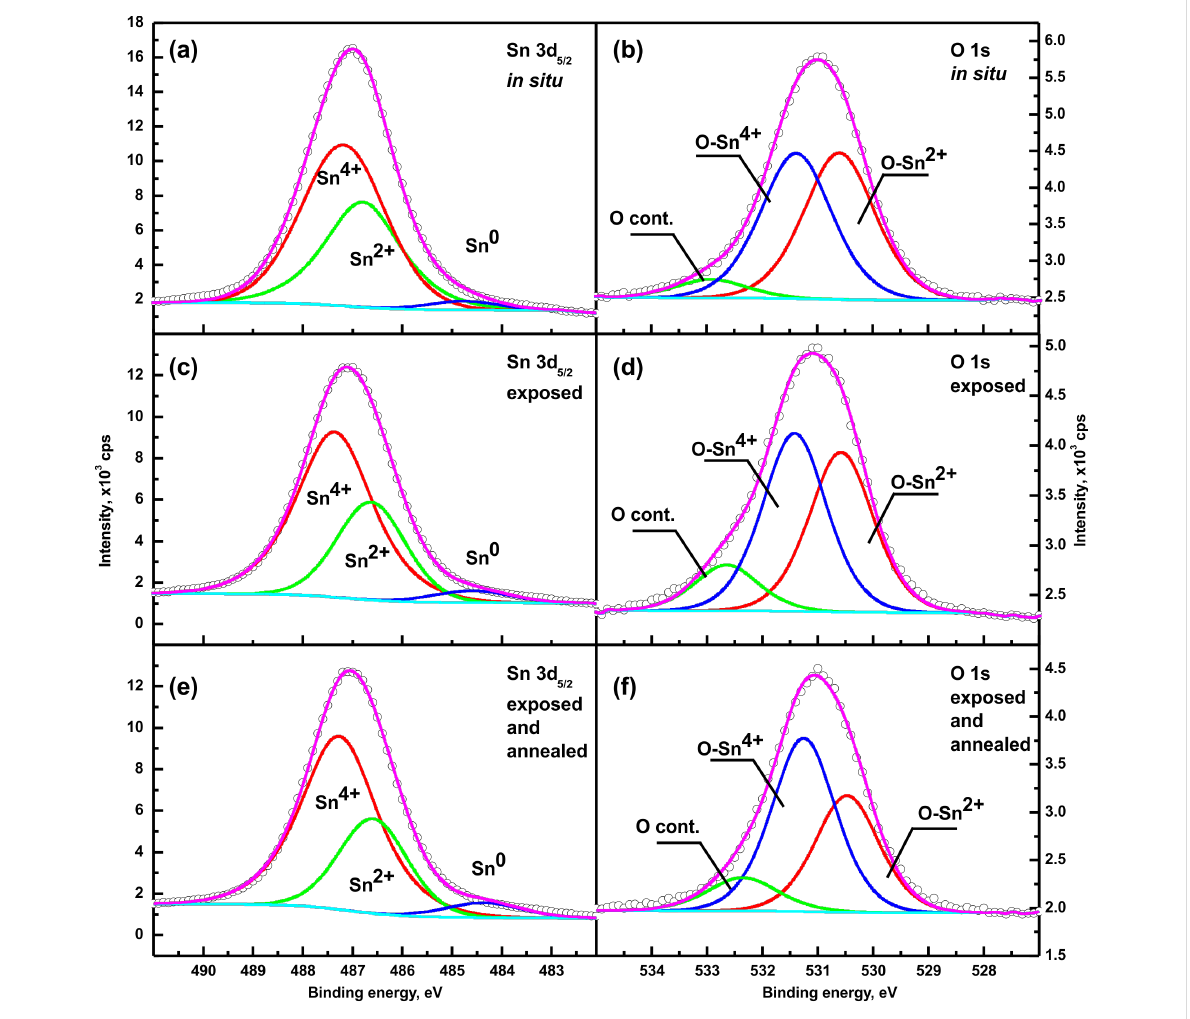
Figure 2: The decomposed Sn 3d 5/2 and O 1s XPS lines of RGVO SnO 2 nanolayers for pristine (“in situ”) samples (a and b), after air exposure (c and d), and after their subsequent UHV annealing (e and f). The cyan line in all panels refers to background level fitted with a Shirley function.